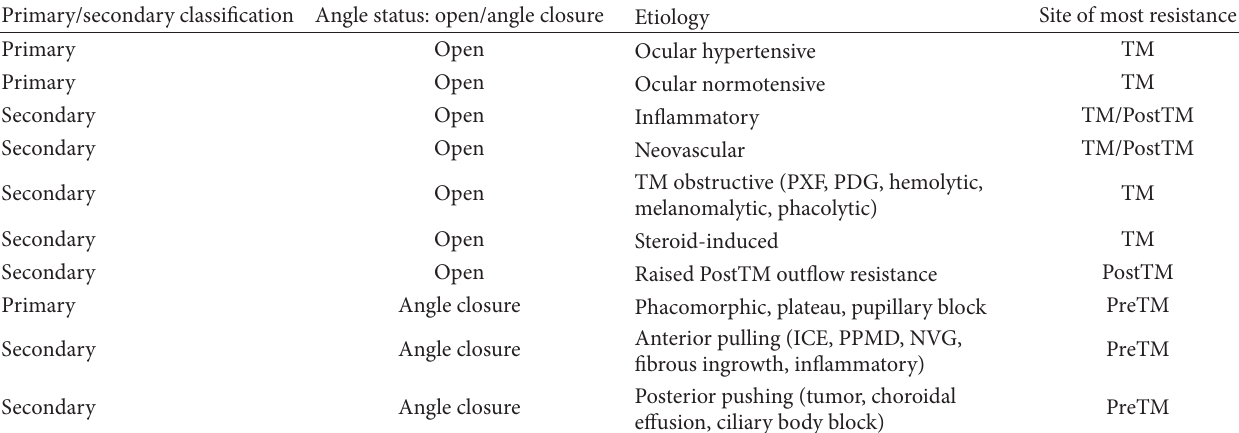
Table 3: Revised classification of glaucoma